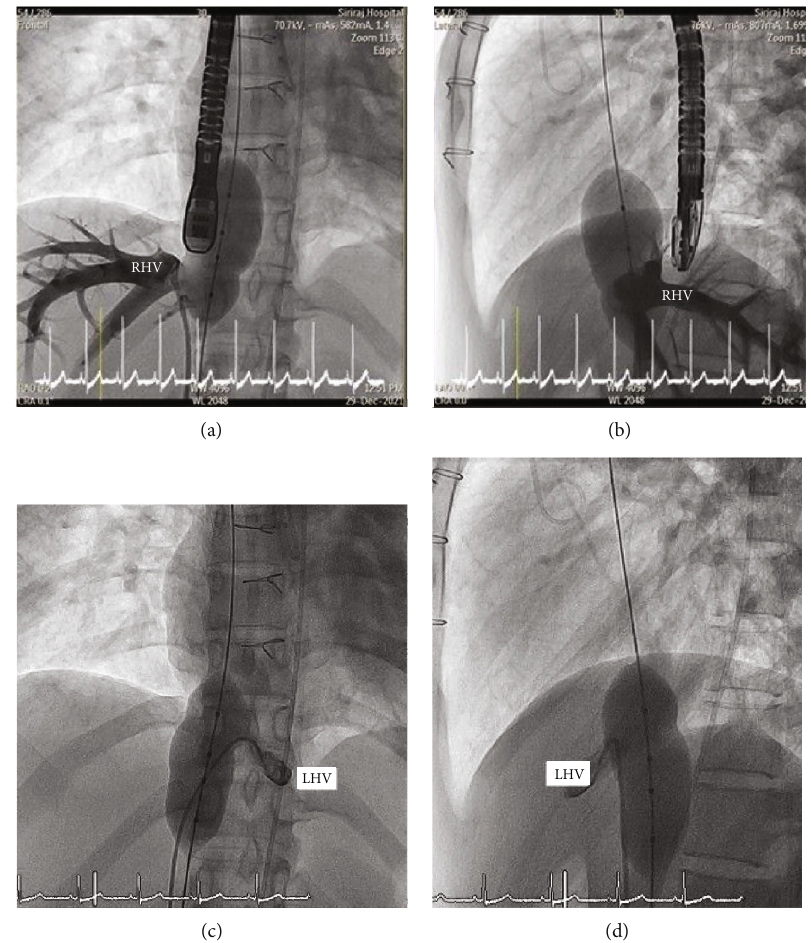
Figure 9: Balloon sizing of the sinus venosus defect that was performed at the inferior vena cava (IVC)-right atrium junction ((a) anterior and (b) lateral views on angiography) showed the right hepatic vein (RHV) to be occluded by the balloon. During the same occlusion, we placed a catheter in the left hepatic vein (LHV) and simultaneously injected contrast showing the LHV connection ((c) anterior and (d) lateral